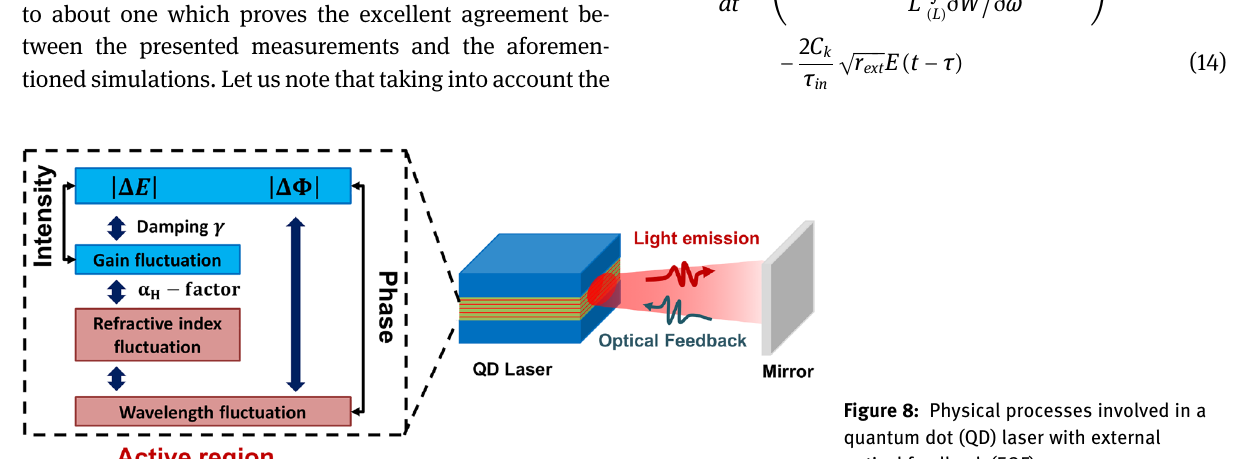
Figure 8: Physical processes involved in a quantum dot (QD) laser with external optical feedback